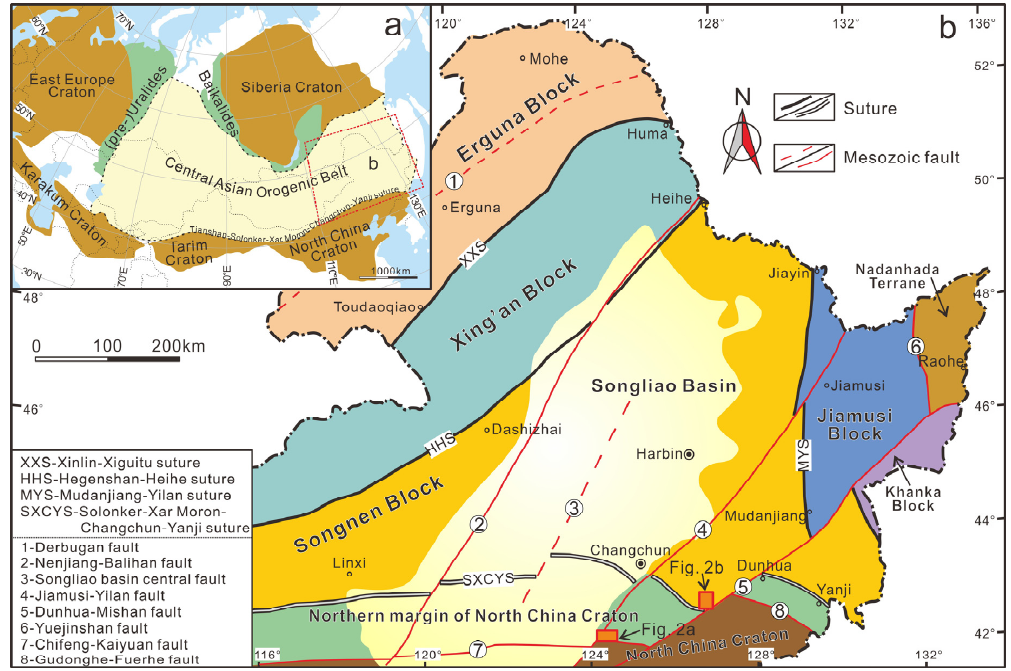
Figure 1. ( a ) Tectonic outline of the Central Asian Orogenic Belt (CAOB) and surrounding regions (modified from the work in [ 27 ]); ( b ) Tectonic sketch map of NE China (modified from the work in [ 11